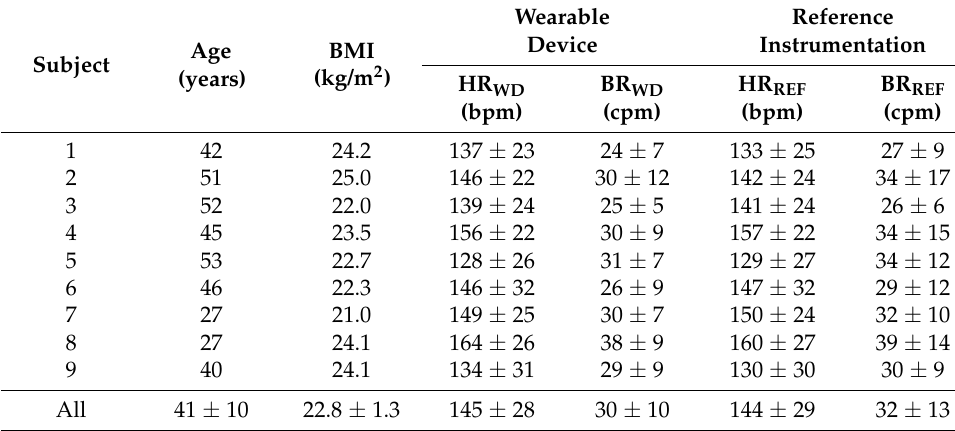
Table 3. Distributions of the predictors.